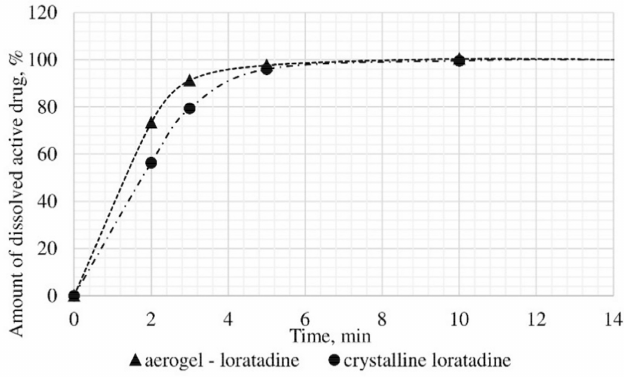
Figure 13. Results of in vitro dissolution test for loratadine loaded alginate-based